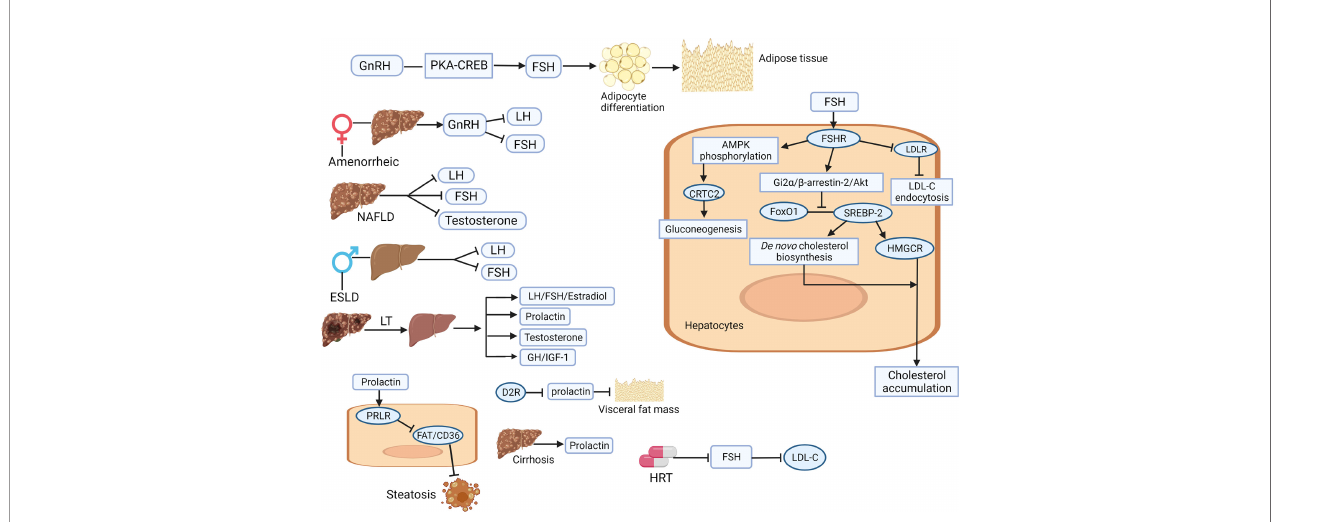
FIGURE 2 | Illustration of the involving mechanisms of sex-related hormones (gonadotrophin-releasing hormone, luteinizing hormone, follicle-stimulating hormone, and prolactin) in liver physiology and pathology. GnRH increases the secretion of FSH through the PKA/CREB pathway, accelerates the differentiation of adipocytes in adipose tissue, which fi nally lead to hepatic fat accumulation. In amenorrhoea females with cirrhosis, abnormal GnRH secretion leads to low LH and FSH levels. FSH interacts with FSHR to reduce the level of LDLR, weaken the endocytosis of LDL-C, and lead to the increase of circulating LDL-C. After HRT treatment, FSH is inhibited and LDL-C content is improved. FSH activates Gi2 by binding to liver FSHR a / b -Arrestin-2/Akt pathway, which subsequently inhibits the binding between FoxO1 and SREBP-2, drives HMGCR transcription and de novo cholesterol biosynthesis, resulting in increased cholesterol accumulation. Liver transplantation can improve the hormone disorder related to chronic liver disease by restoring the circulating physiological levels of estradiol, FSH, LH, prolactin, testosterone, GH and IGF-1. Inhibition of prolactin by D2R activation leads to reduction of visceral adipose tissue. Prolactin improves hepatic steatosis through PRLR down regulation of FAT/CD36. Prolactin levels are signi fi cantly increased in patients with liver cirrhosis. Akt, protein kinase B; AMPK, adenosine monophosphate-activated protein kinase; CREB, cAMP response element binding protein; ESLD, End-stage liver disease; FAT, fatty acid translocase; FoxO1, forkhead box protein O1; FSH, follicle- stimulating hormone; FSHR, FSH receptor; GH, growth hormone; GnRH, gonadotrophin-releasing hormone; HMGCR, 3-hydroxy-3-methylglutaryl coenzyme A reductase; HRT, hormone-replacement therapy; IGF, insulin growth factor; LDL, low-density lipoprotein; LDL-C, low-density-lipoprotein cholesterol; LDLR, LDL receptor; LH, luteinizing hormone; LT, liver transplantation; PKA, protein kinase A; PRLR, prolactin receptor (Created with Biorender.com with a publication